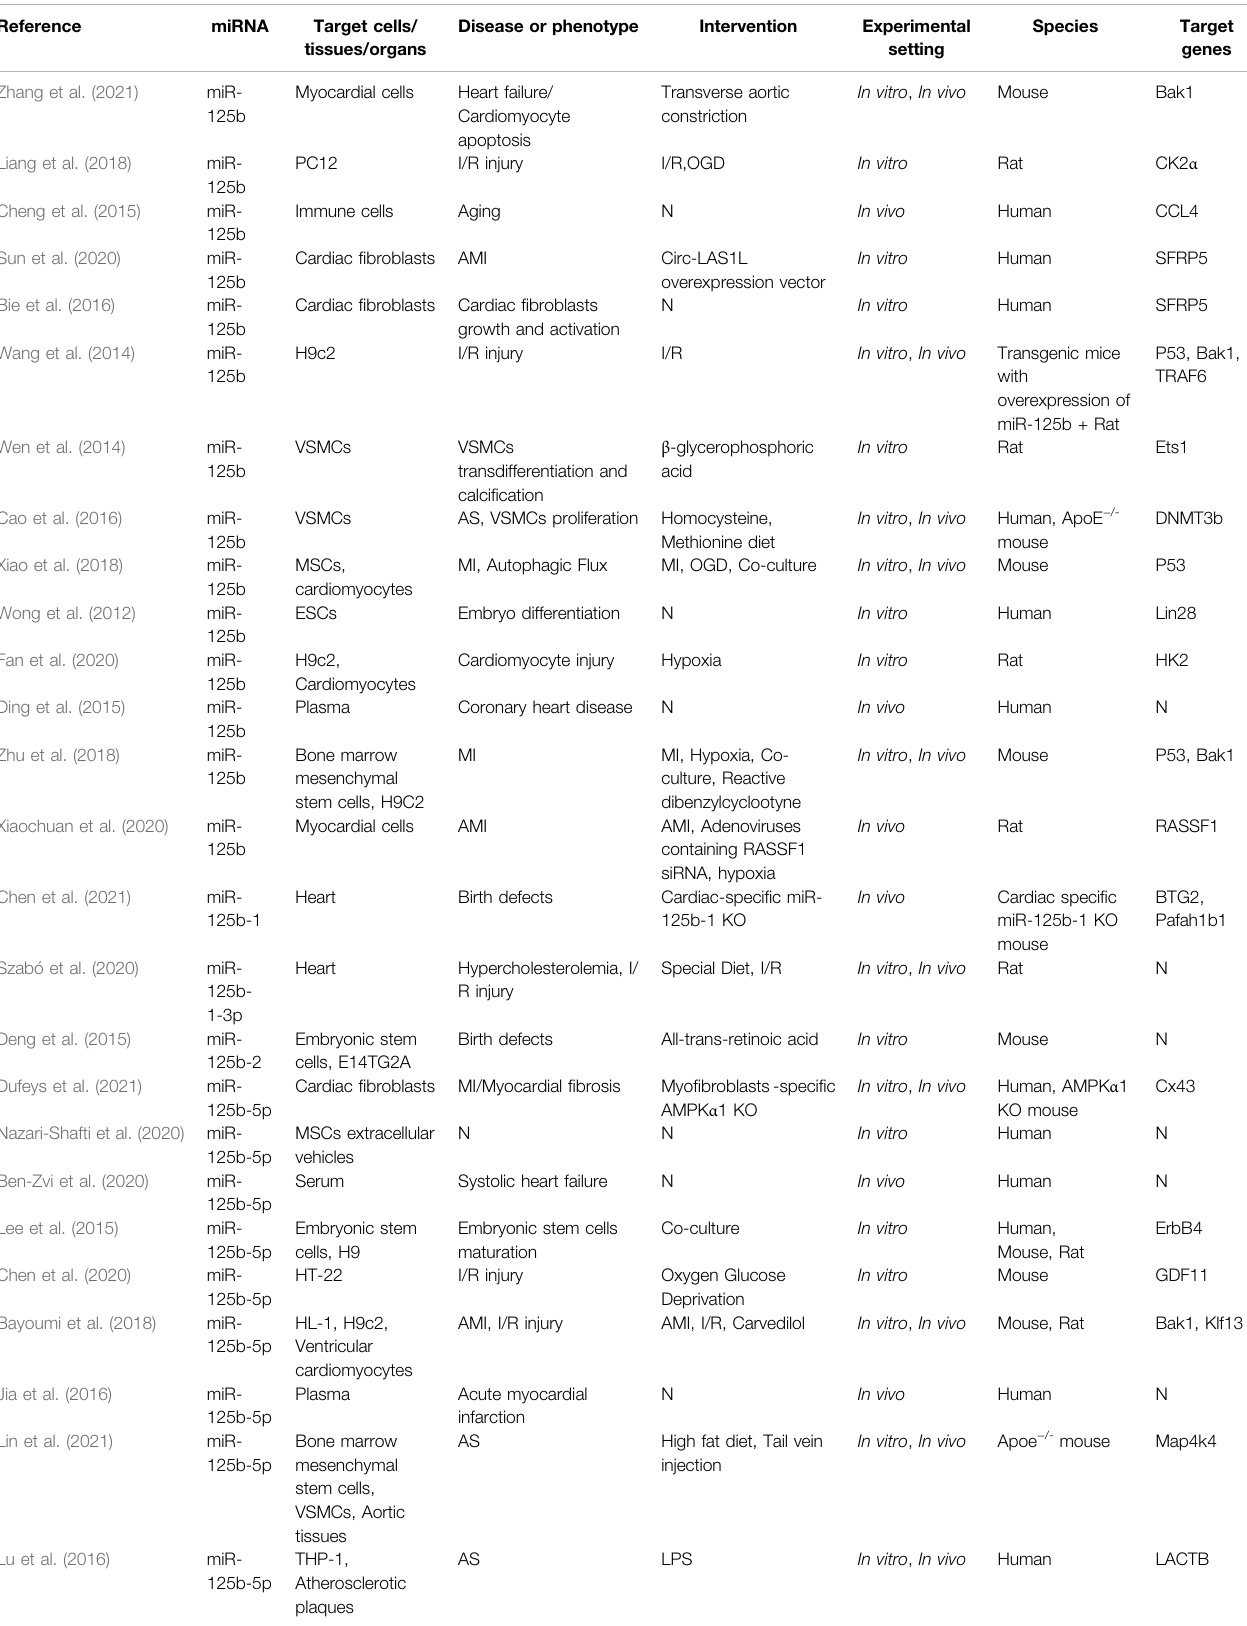
TABLE 1 | ( Continued ) Summary of studies investigating the regulators and effectors of miR-125 family in cardiovascular and cerebrovascular